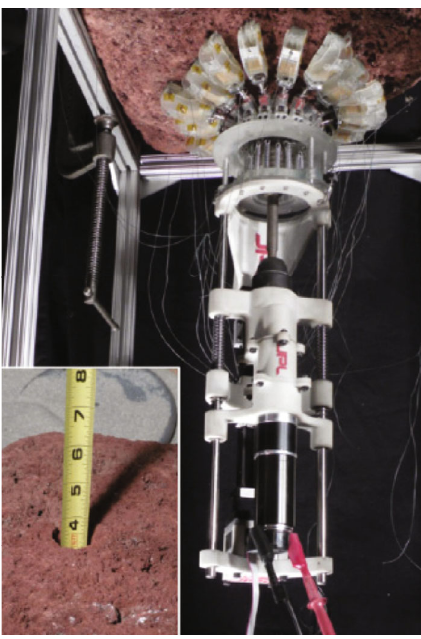
Figure 5: Microspine anchor device by elastic